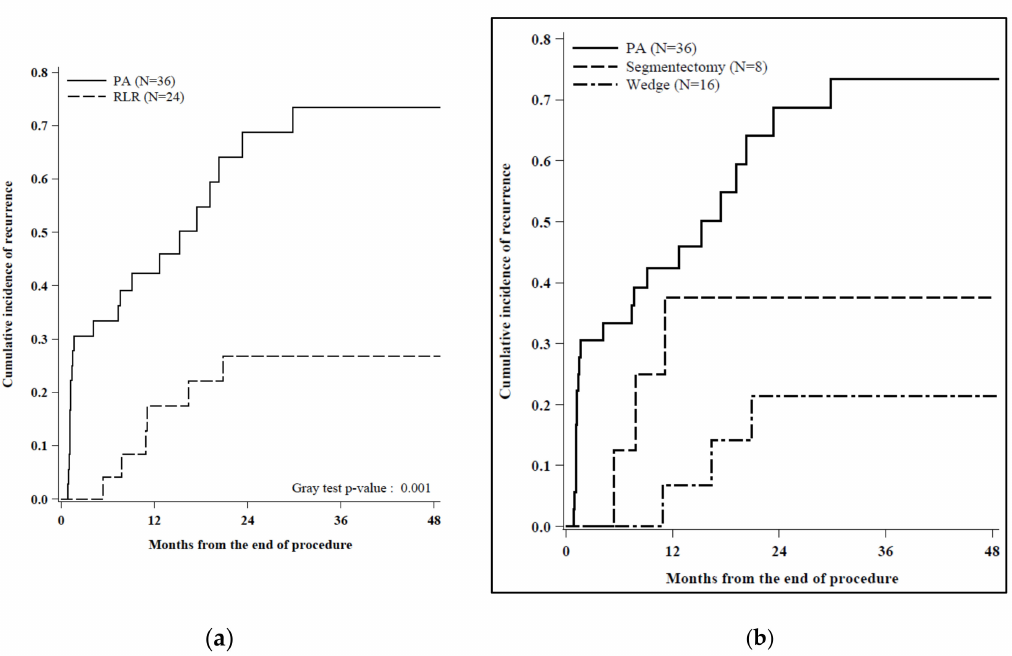
Figure 4. ( a ) Cumulative incidence of recurrence by procedure ( N = 60): Recurrence as first event was considered as “Event”. Transplant or reoperation / locoregional treatment postresection or death as first event was considered as “Competing event”. No event at the last follow-up was considered as “Censored”. Of the 22 patients that experienced a recurrence in the PA group, 12 were perilesional and 10 were not, while all the 6 cases of recurrence in the RLR group were not perilesional. ( b ) Cumulative incidence of recurrence by procedure, stratified by the RLR type of resection: Recurrence as first event was considered as “Event”. Transplant or reoperation / locoregional treatment postresection or death as first event was considered as “Competing event”. No event at last FU was considered as “Censored”. Events: recurrence ( N = 22 in PA (12 perilesional and 10 not perilesional), N = 3 in segmentectomy (3 not perilesional and N = 3 in Wedge (3 not perilesional)). Competing events: transplant ( N = 1 in PA, N = 2 in segmentectomy, and N = 2 in Wedge) and death ( N = 1 in PA, N = 1 in segmentectomy, and 2